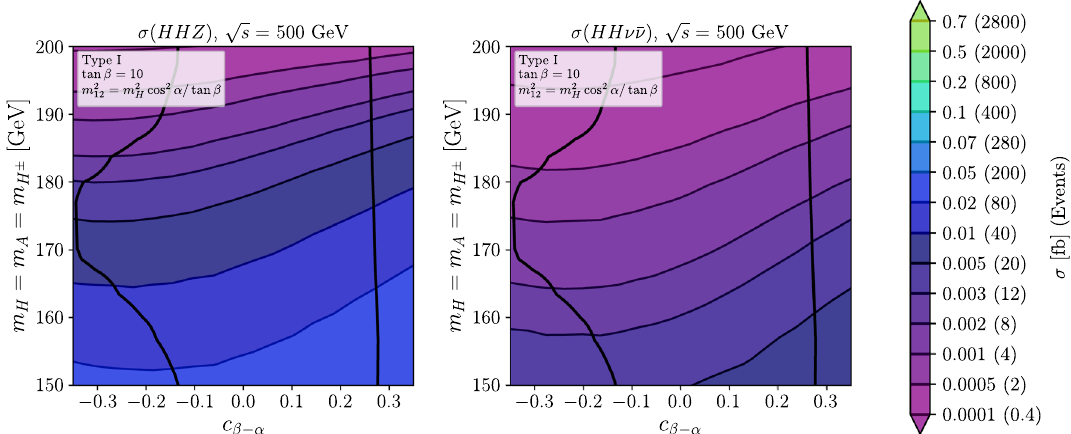
√ s = 500 GeV for our benchmark plane 3. The total allowed regions is given